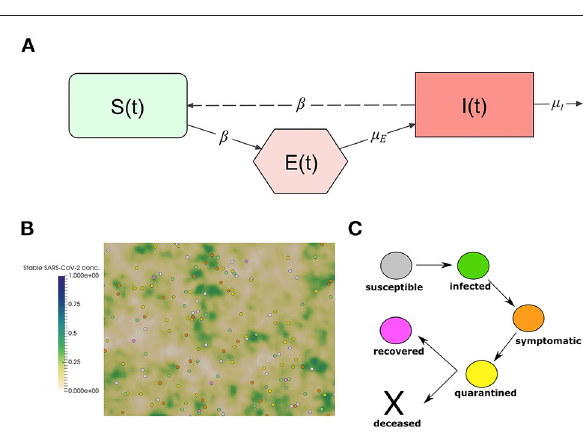
FIGURE 1 | (A) Interactions between the compartments of the epidemiological model (1). The continuous lines represent transition between compartments, and entrance and exit of individuals. The dashed line represents the transmission of the infection through the interaction between susceptible and infected individuals. (B) Snapshot of a numerical simulation of the model. Spheres represent individual people moving in a square section of 250 × 250 m. The color of each individual represents the class to which it belongs: white for susceptible, green for infected, orange for symptomatic, yellow for quarantined, and pink for recovered. The concentration of stable SARS-CoV-2 on surfaces is represented using the gradient of the green color. (C) The clinical course of COVID-19 patients in the